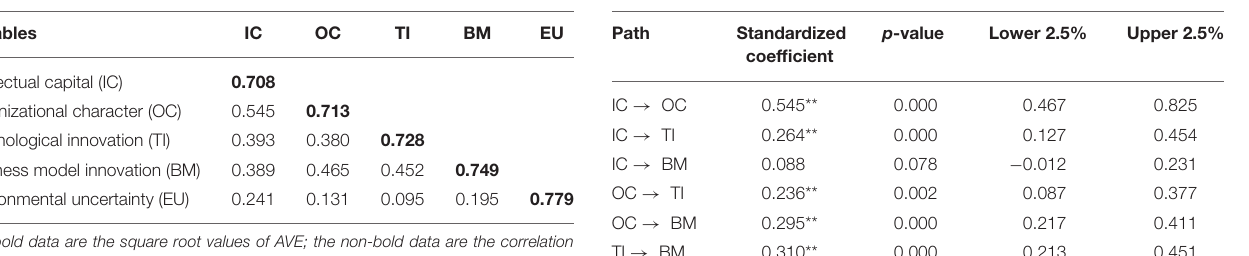
TABLE 4 | Discriminant validity. TABLE 5 | Standardized path